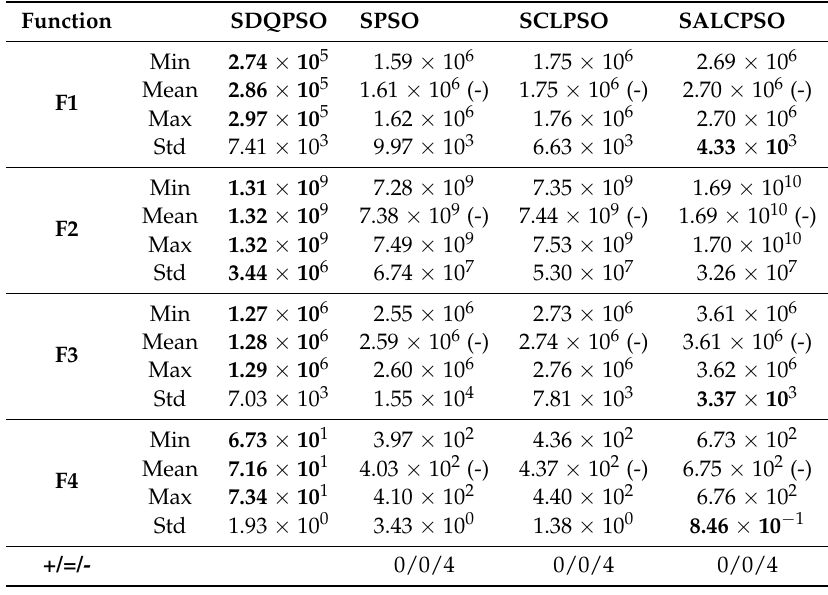
Table 3. Optimization performance on four